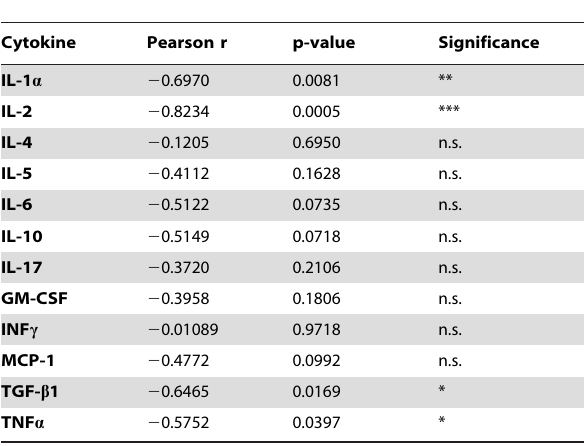
Table 1. Correlation between cytokines and TH neurons.